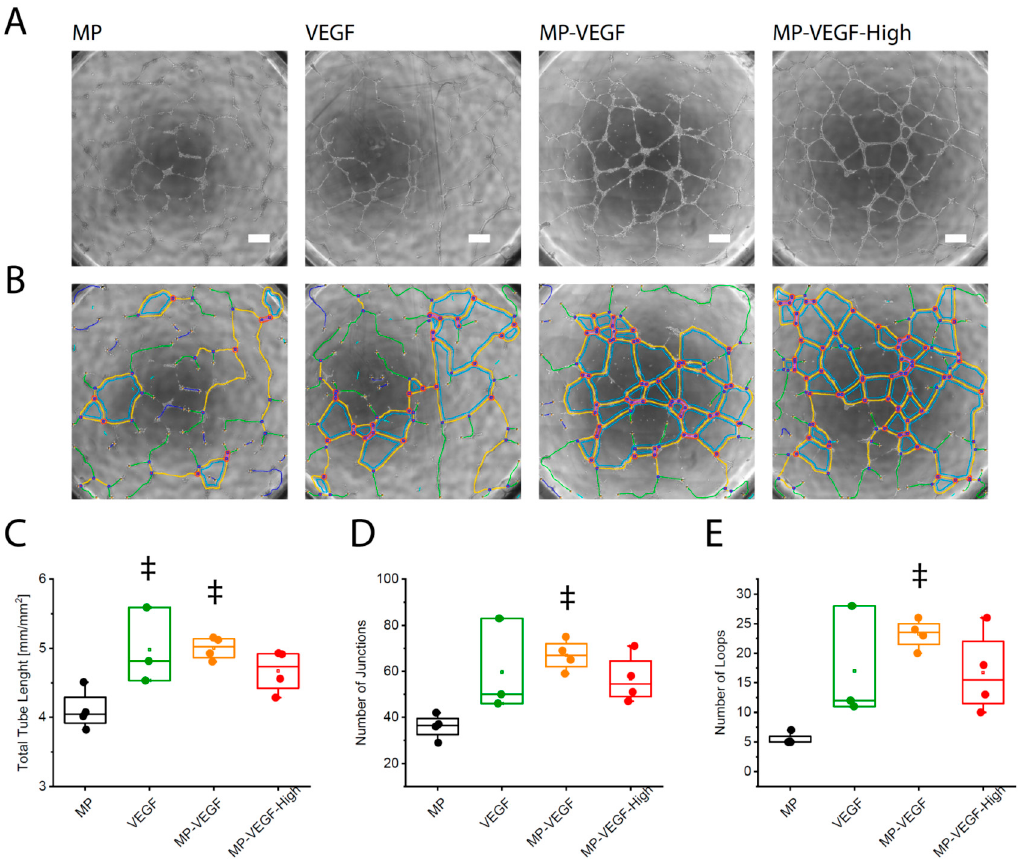
Figure 3. 2D capillary network formation. Capillary-like network formation by endothelial cells on growth factor-reduced Matrigel affected by addition of microparticles releasing VEGF-A. ( A ) Morphology of vascular networks after 24 h and ( B ) evaluation with the Angiogenesis Analyzer ImageJ plugin; red dots indicate junctions, blue lines indicate loops, scale bar: 300 µm. MP: microparticles, MP-VEGF: microparticles releasing VEGF-A (50 ng/mL initial loading), MP-VEGF-H: microparticles releasing high concentration of VEGF-A (100 ng/mL initial loading). ( C ) Total vascular tube length. ( D ) Number of junctions. ( E ) Number of loops, ‡ indicates significant di ff erence comparing to samples containing microparticles alone ( p < 0.05) evaluated by one-way ANOVA.